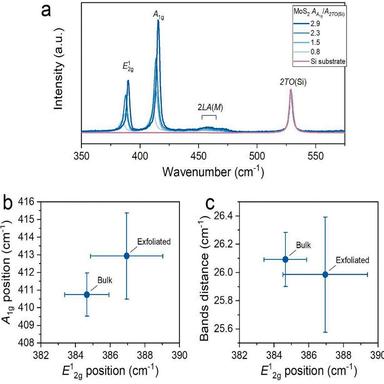
(a) Representative Raman spectra of MoS2 flakes with different and ratios. (b) band position and (c) distance between bands as a function of the band position.